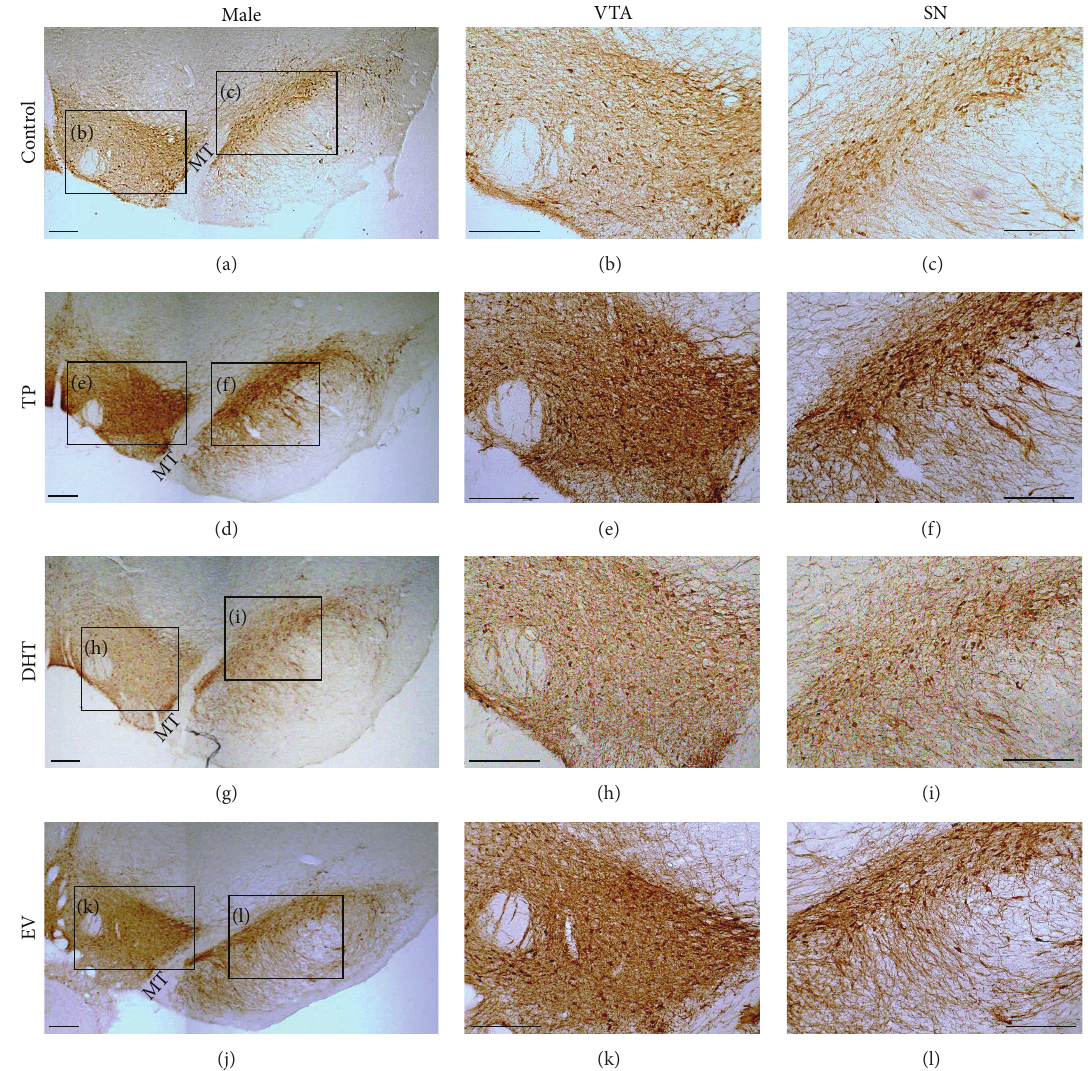
Figure 2: Effect of neonatal exposure to sesame oil (control: a, b, c), testosterone propionate (TP: d, e, f), dihydrotestosterone (DHT: g, h, i), or estradiol valerate (EV: j, k, l) on tyrosine hydroxylase-immunoreactive neurons in ventral tegmental area (VTA: b, e, h, j) and substantia nigra (SN: c, f, i, l) of adult male rats (control 𝑛 = 3 , TP = 4, DHT = 2 and EV = 5). Scale bars = 400 𝜇 m. MT: medial terminal nucleus of accessory optic